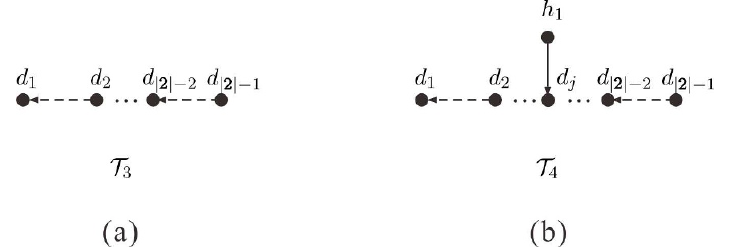
Figure 10 . The terms I 1 and I 2 in eq. (3.15) can be expanded in terms of graph-based BCJ relations (A.13), where the corresponding tree graphs T are chosen as the graph (a) and the graph